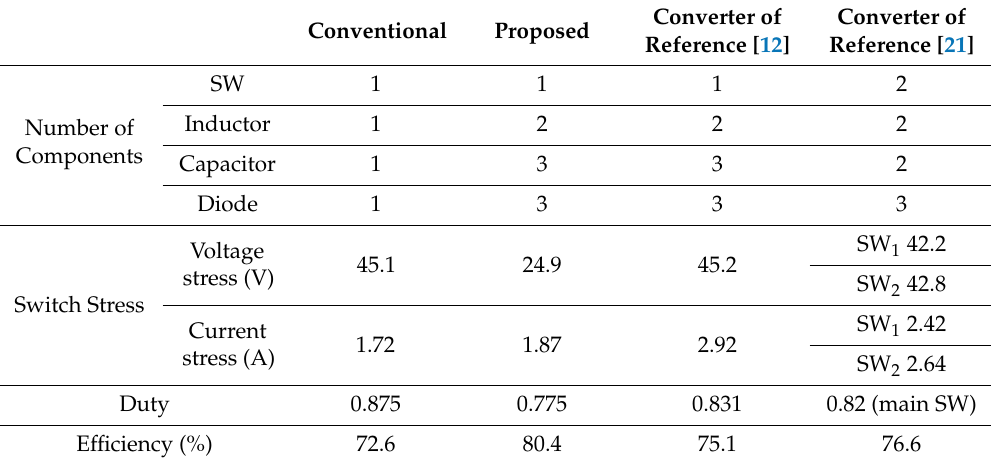
Table 3. Comparison with existing boost